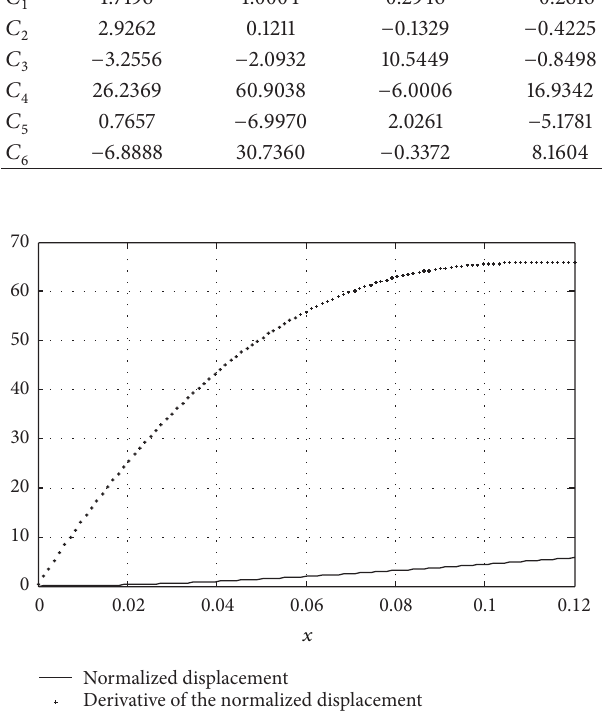
Figure 2: Normalized displacement of the beam and its derivative.